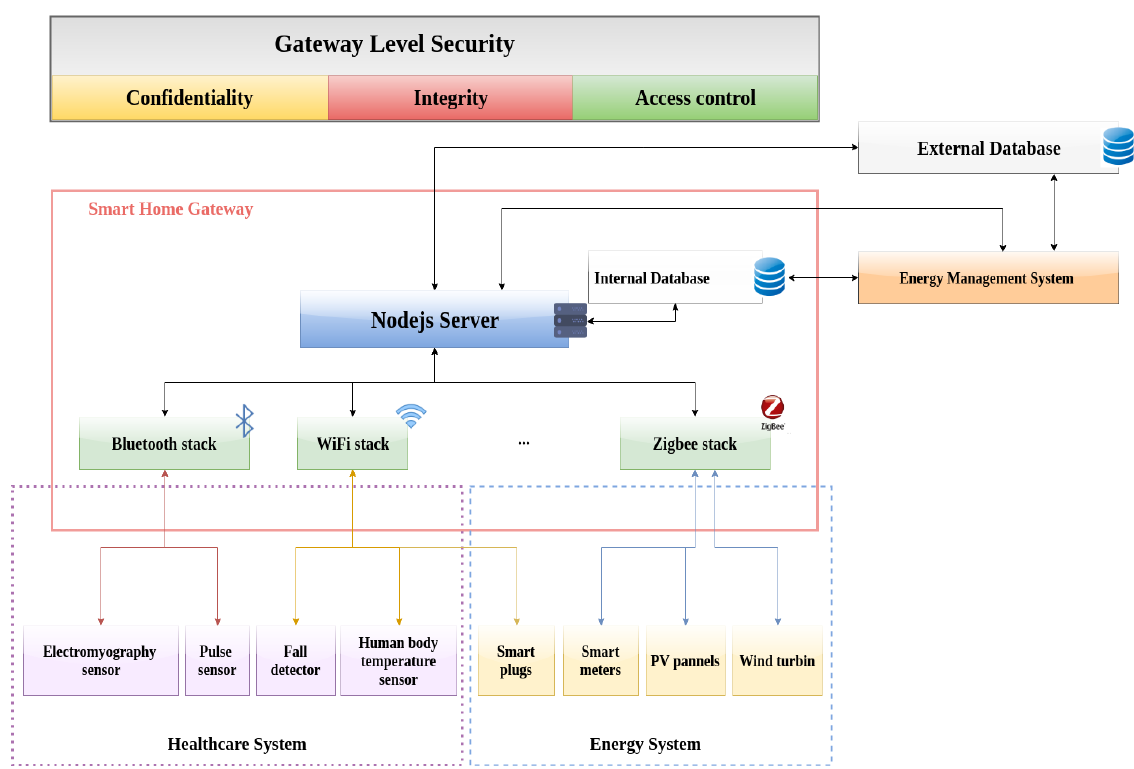
Figure 4. next generation smart home